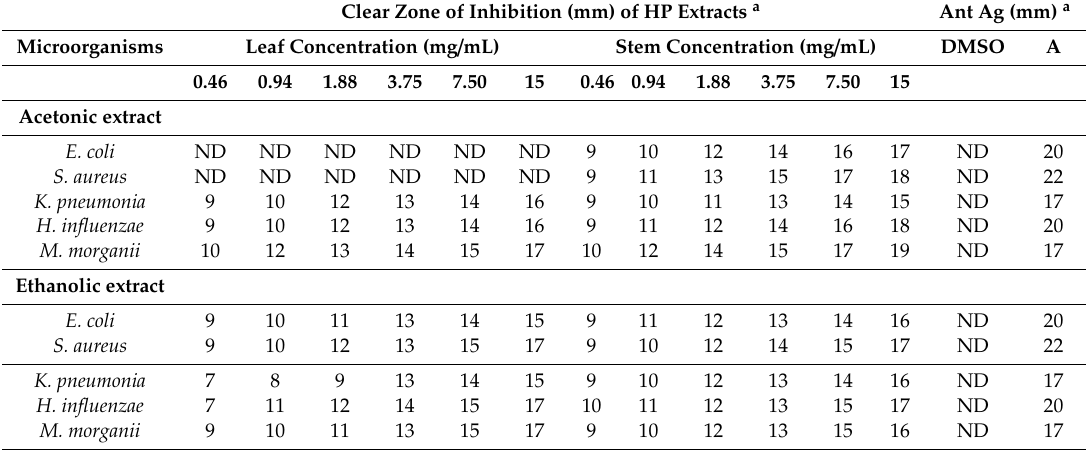
Table 3. Antimicrobial activity of di ff erent solvent extracts of P. hydropiper leaves and stem at di ff erent